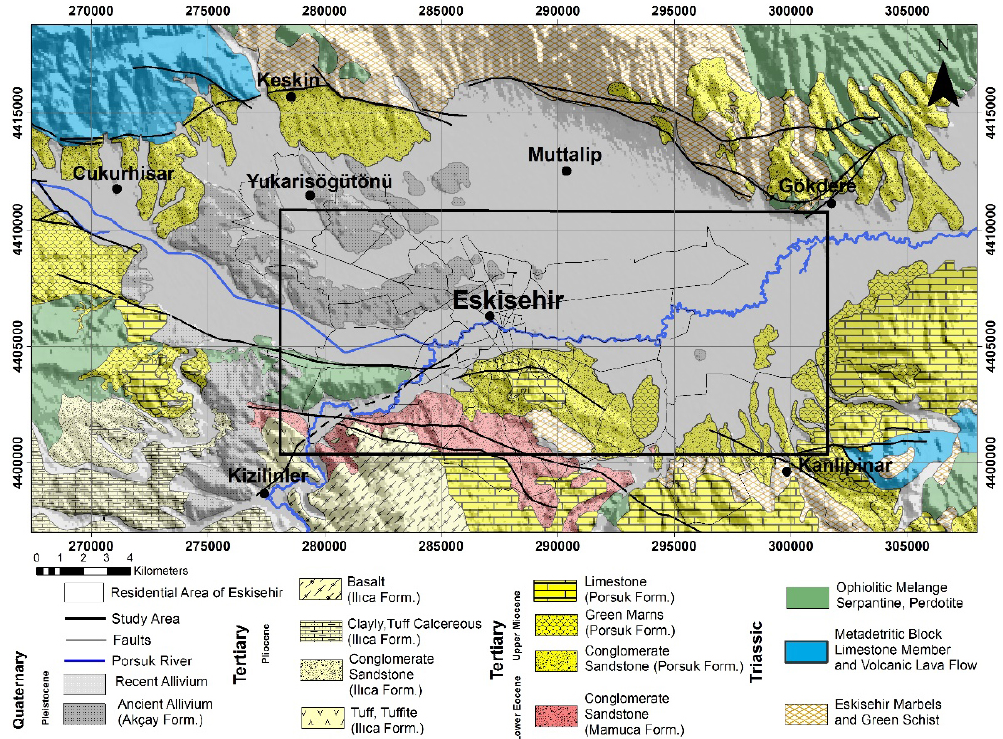
Figure 2. The geological map of Eski¸sehir (modified from Orhan et al., 2007).